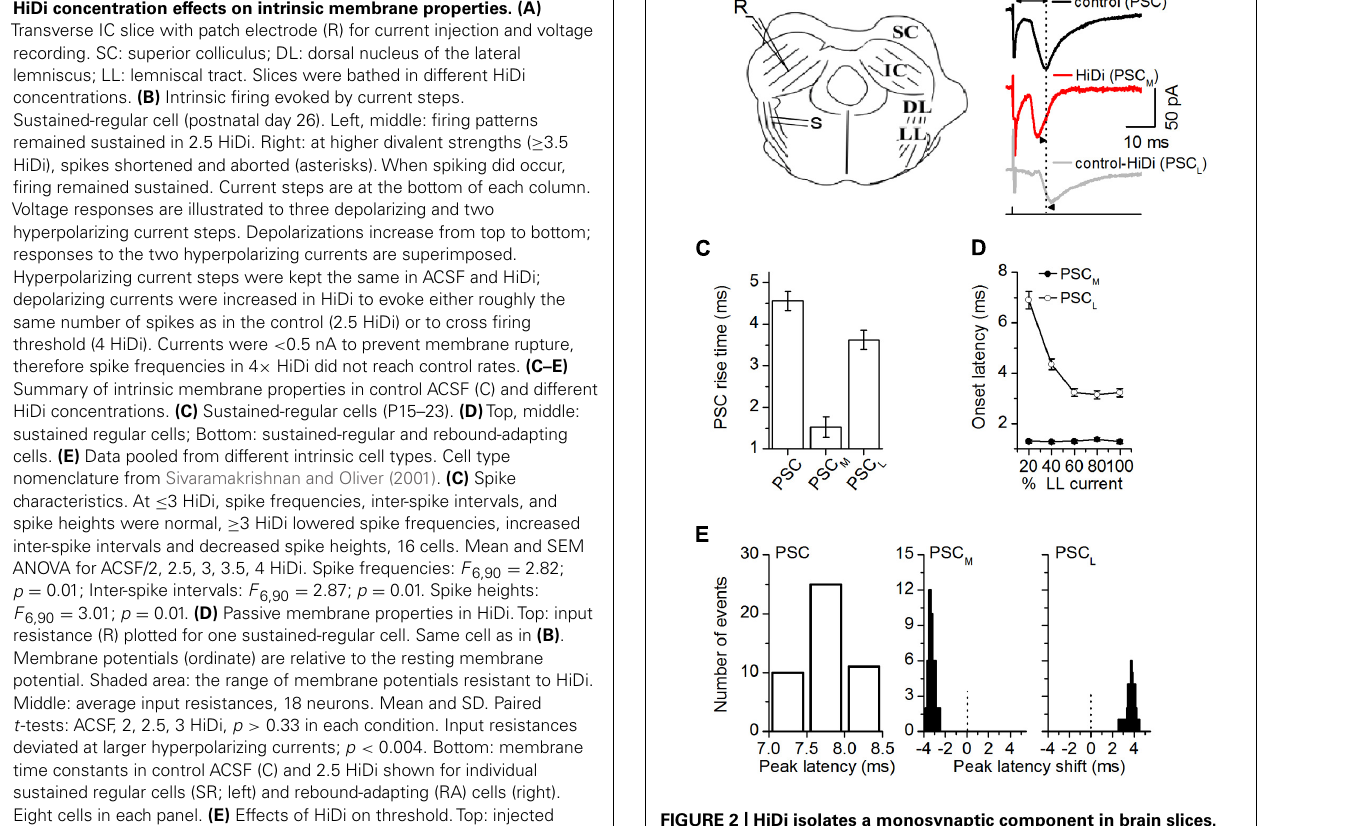
FIGURE 2 | HiDi isolates a monosynaptic component in brain slices. (A) Transverse IC slice. SC: superior colliculus; DL: dorsal nucleus of the lateral lemniscus; LL: lemniscal tract. S: stimulation LL tract. R: recordings in the central region of the IC. (B) PSCs evoked by LL stimulus currents set at 50% above threshold levels. PSC: normal ACSF. PSC M : monosynaptic component of the PSC that remains in HiDi. PSC L = PSC − PSC M ; the local component blocked by HiDi. Double arrow, top trace: latency of the PSC peak measured from the stimulus artifact. Dotted vertical line is lined up to the peak of the PSC. Arrowheads, second and third traces: PSC M and PSC L peaks are shifted from PSC. (C) The rise time of PSC M was faster than that of PSC L (1.5 ± 0.2 and 3.6 ± 0.2 ms; t 23 = 3.38; p = 0.0026). Rise times were measured between 10 and 90% of the rising phase, 24 cells. Mean and SEM. (D) Variation of PSC onset latency with LL stimulus current confirmed that PSC M and PSC L had monosynaptic and polysynaptic sources.The maximum stimulus current strength (100% LL current) is defined as the current beyond which no further increases in PSC amplitude or duration occur. PSC M onset latencies had a SD < 1, and remained constant as LL stimulus currents increased (Mean and SD: 1.31 ± 0.16 ms, n = 21 cells; 5 stimulus current strengths, F 5,100 = 0.4; p = 0.84). PSC L onset latencies shortened as stimulus currents increased (6.9 ± 0.4 to 3.23 ± 0.3 ms; n = 21 cells; F 5,100 = 3.7; p = 0.004). Single LL shock. Onset latency was measured between the stimulus artifact and the time corresponding to a 10% deviation of the PSC from baseline, 21 cells. Mean and SD. (E) Distribution of the latencies and latency shifts of PSC peaks. Measurements of latency of the control PSC and latency shifts of PSC M and PSC L are illustrated in (B) . Left: absolute peak latencies of PSC; Middle, right: PSC peak latencies (7.76 ± 0.009 ms; n = 46 cells) were normally distributed. Peak latency distributions of both PSC M and PSC L were skewed. PSC M preceded PSC by − 3.32 ± 0.036 ms ( t 179 = 3.72; p = 0.0002), but PSC L followed PSC by 3.78 ± 0.063 ms ( t 179 = 2.62; p = 0.009). Abscissa range of − 3 to 1 indicates latencies relative to PSC, which is set at zero (dotted vertical lines). Gaussian fits r 2 values, mean, and SEM PSC: 0.9974, 7.76 ± 0.009; PSC M : 0.8788, − 3.3 ± 0.03; PSC L : 0.7369, 3.78 ± 0.06, 46 cells. (B–E) 2.5